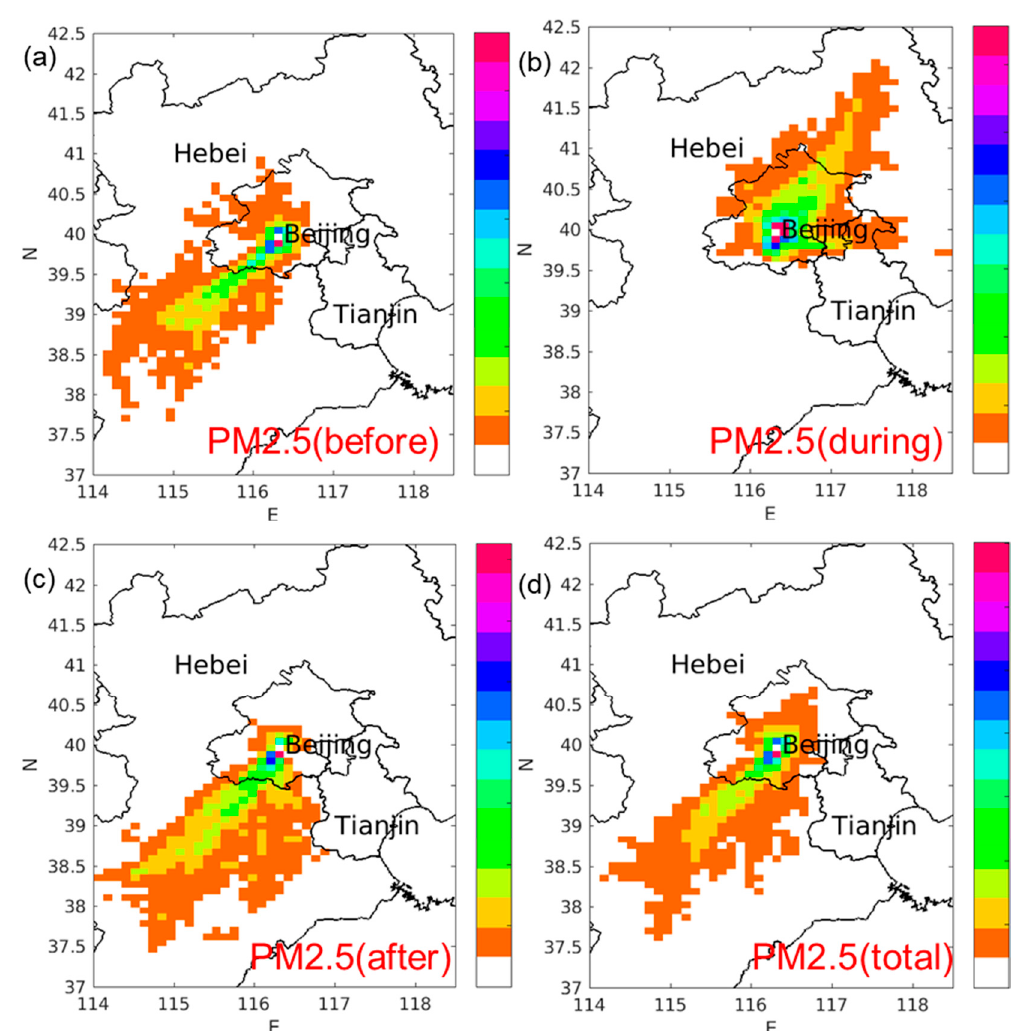
Figure 9. CFA fields plots of PM 2 . 5 , OC, and EC in 3 time periods. Subplots ( a – d ) are CFAs of PM 2 . 5 in 3 time periods and the whole sampling period, respectively. The red dot is the sampling site and particle release point in FLEXPART. The color bar only represents the relative contribution percentage in each grid. Beijing city, Tianjin city, and Hebei Province are marked in the maps. From bottom to top side of the color bar, the cell contribution gets